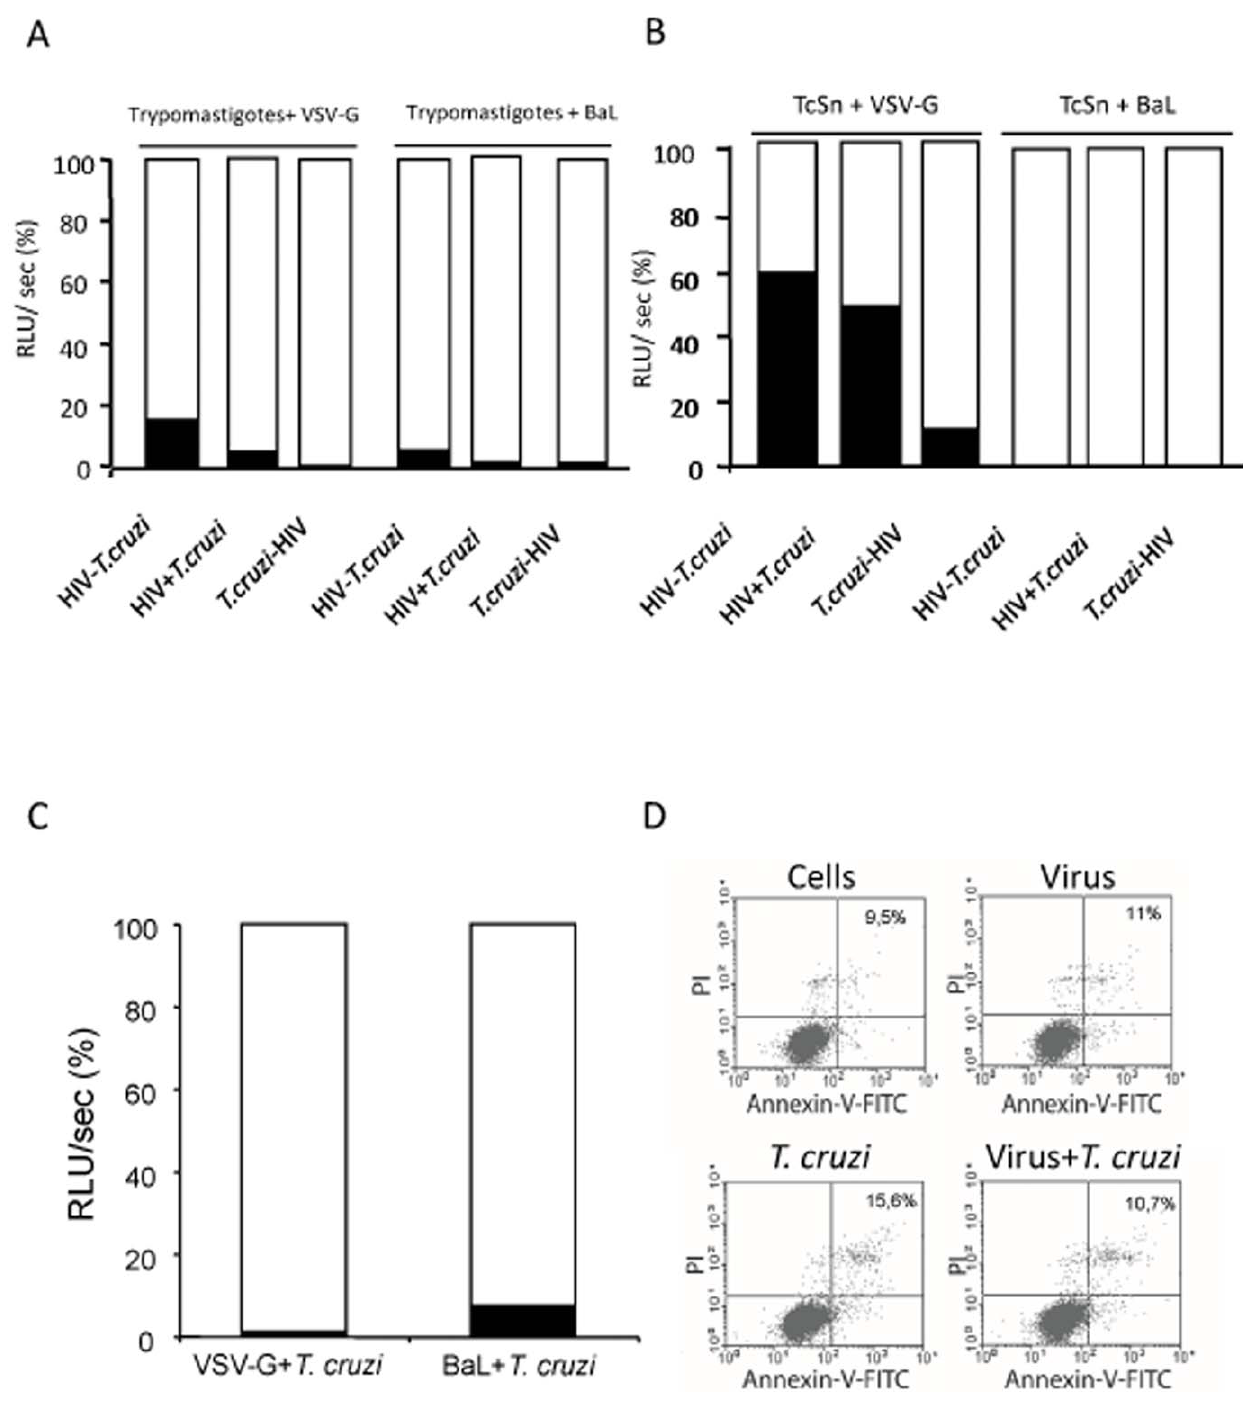
Figure 3. Inhibition of pseudotyped viruses replication by T.cruzi. MDM were infected with both VSV-G or BaL pseudotyped viruses in the presence of T. cruzi blood trypomastigotes ( A ) or trypomastigotes free-supernatant (TcSn) ( B ) in three different schemes: HIV 24 h after T. cruzi ( T. cruzi -HIV), HIV 24 h before T. cruzi (HIV- T. cruzi ) or HIV at the same time as T. cruzi (HIV + T. cruzi ), where T. cruzi indicates either trypomastigotes of TcSn. Luciferase activity was measured from cell lysates 4 days post-viral infection. Results are expressed as relative light units per second (RLU/sec), presented as a percentage relative to the control (100%), where the histogram in white corresponds to the percentage of infection with the respective control virus and the histogram in black corresponds to the percentage of infection in the presence of the parasite. ( C ) MDM were also infected with pseudotyped viruses and cell-derived trypomastigotes, and luciferase activity was evaluated. ( D ) Cell viability was evaluated by flow cytometry at day 4 p.i. in co-infected cells with blood trypomastigotes and controls stained with PI and Annexin-V-FITC. During the analysis 20000 events were acquired and the analysis includes all the ungated cells; percentages of PI and Annexin-V positive cells are indicated. Results are representative of 3 independent experiments performed with cells from different donors.